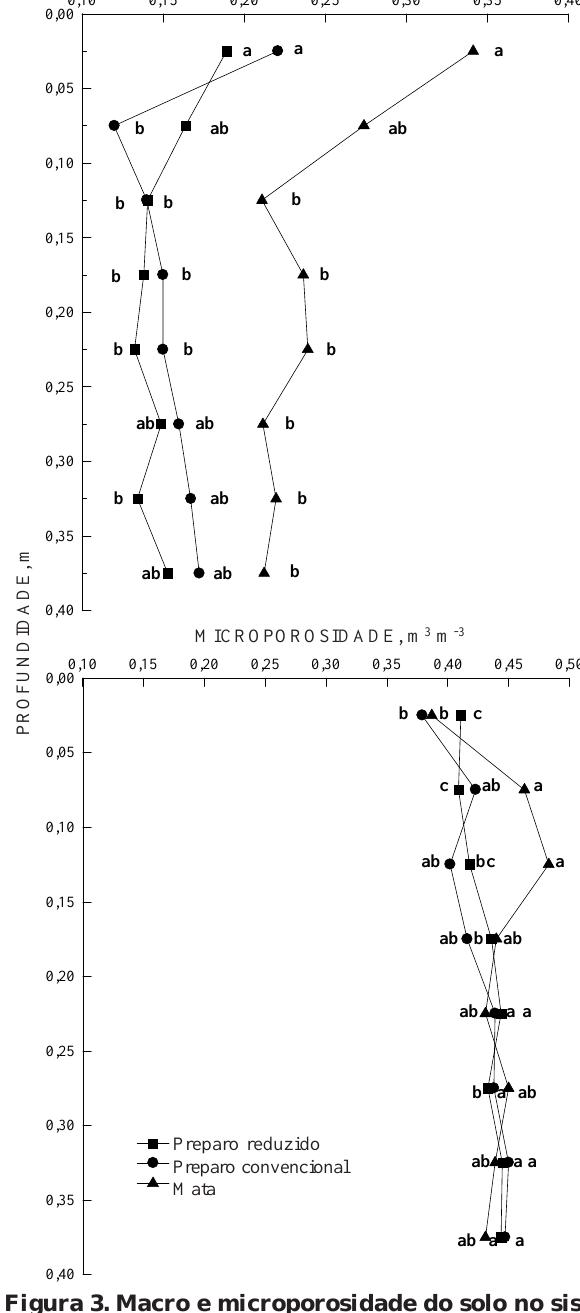
Figura 3. Macro e microporosidade do solo no sis-